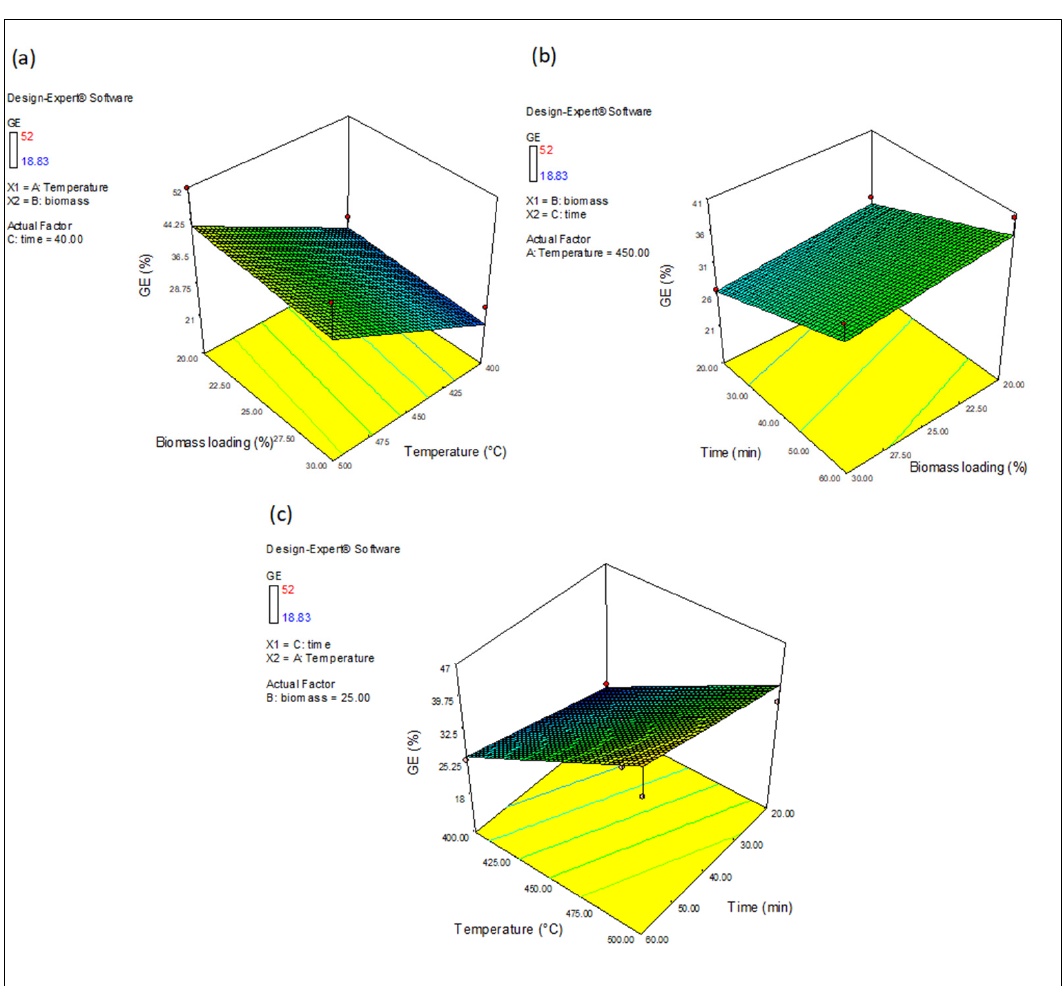
Figure 12. Three-dimensional response surface graphs of interaction effects of variables biomass concentration, temperature and time ( a – c ) on (GE).